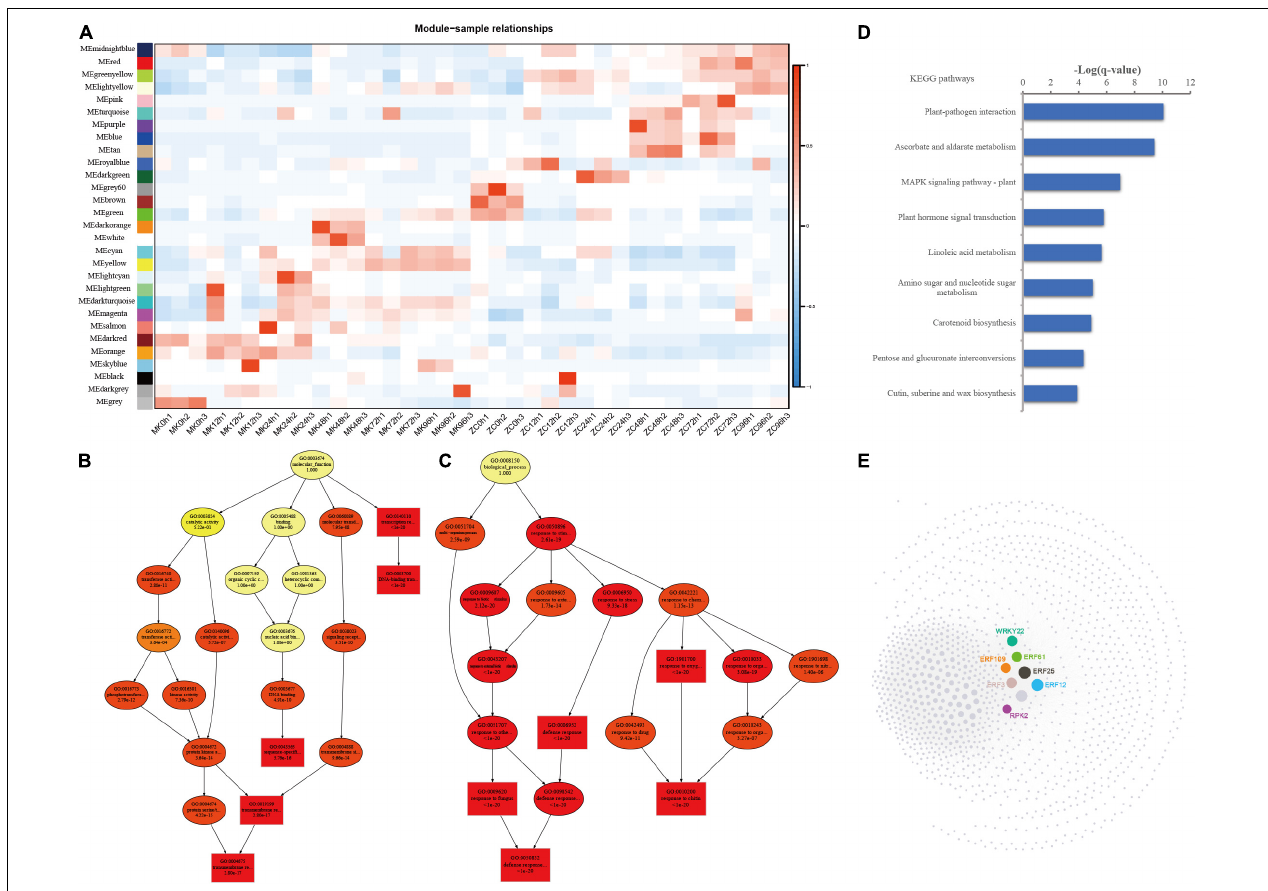
FIGURE 5 | WGCNA of the transcripts and functional analysis of genes in the yellow module. (A) Module-sample relationship. (B,C) Directed acyclic graph (DAG) of genes in the yellow module in the Biological Process (D) and Molecular Function (E) categories. (D) KEGG analysis of the genes involved in the yellow module. The data were calculated by –log 10 ( p -value). (E) Coexpression network of the genes clustered in yellow